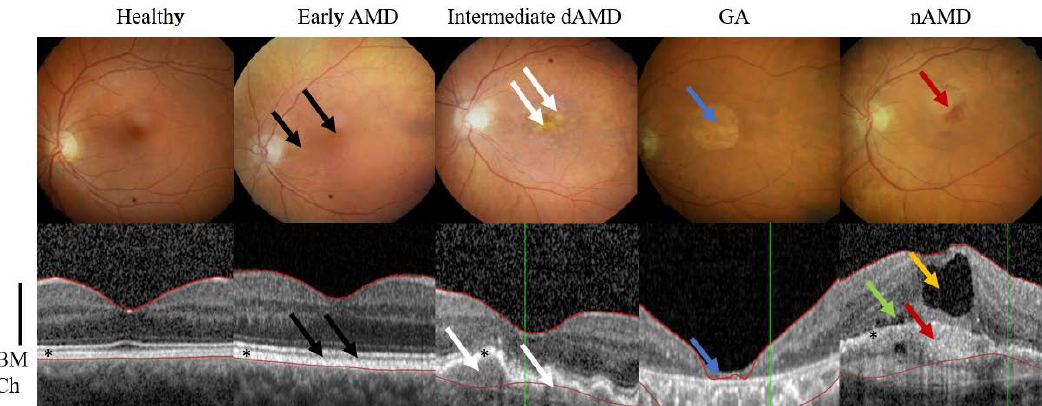
Figure 1. Fundus photographs (upper panel) and optical coherent tomographs (lower panel) from healthy individual, early AMD with pigment mottling (black arrows), intermediate dAMD with drusen (white arrows), GA (blue arrows) and nAMD with choidal neovascularization and hemorrhage (red arrows) that coincide with intra- (yellow arrow) and subretinal (green arrow) fluids. Black column indicates neural retina and asterisk the RPE layer that both are atrophic or missing in GA. Abbreviations: AMD, age-related macular degeneration; BM, Bruch’s membrane; Ch, choriocapillaris; d, dry; GA, geographic atrophy; n, neovascular and RPE, retinal pigment epithelium. Note that BM (red line) is not optically recognized right when pathology increases and thus it starts to wave.